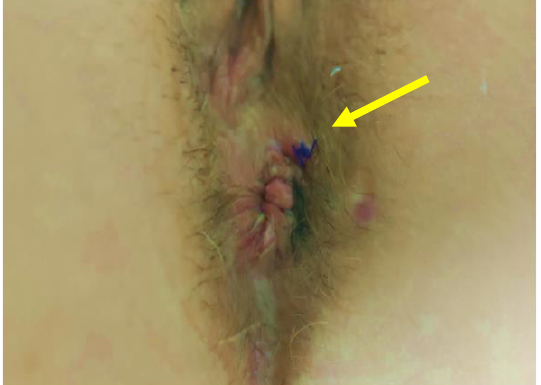
Figure 7. View of the perianal area 7 days after the hAM implant: no inflammation at the previous external anal fistula opening (arrow).